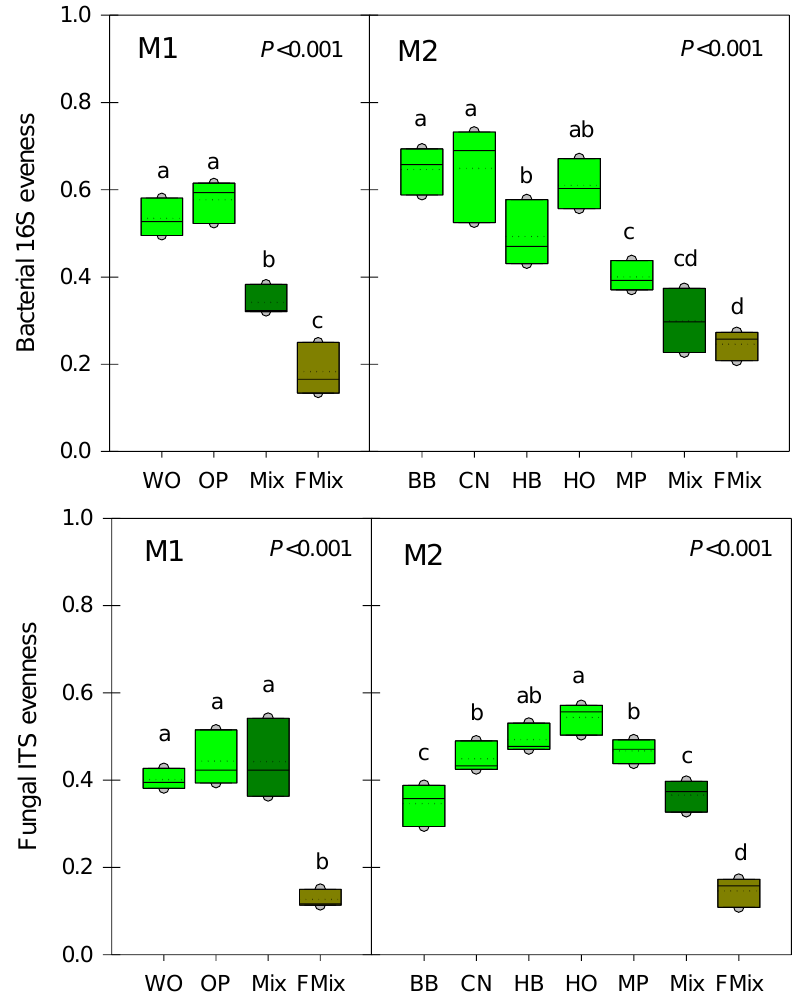
Figure 2. Differences in bacterial ( above ) or fungal ( below ) diversity in the two mixtures of forest litters M1 (WO: white oak, OP: holm oak and Aleppo pine) and M2 (BB: bamboo, CN: chestnut, HB: hackberry, HO: holm oak, MP: maritime pine). Mix: mixture of litters before fermentation, FMix: mixture of litters after fermentation. Different letters above the boxes indicate significant differences ( p < 0.001) among litters.